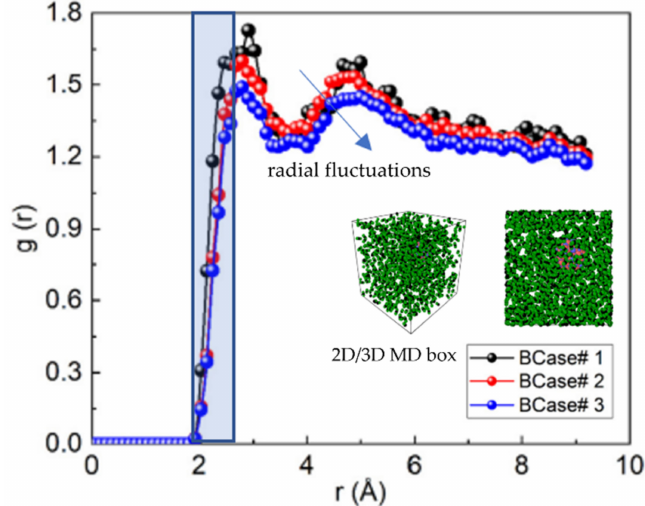
Figure 3. Radial spreading functions of (O-O) band in CO 2 liquid at various molecule-size conditions, T = 380 (K), p = 200 (bar). (For an in-depth interpretation of these data, readers are referred to the Mahdavi et al. paper